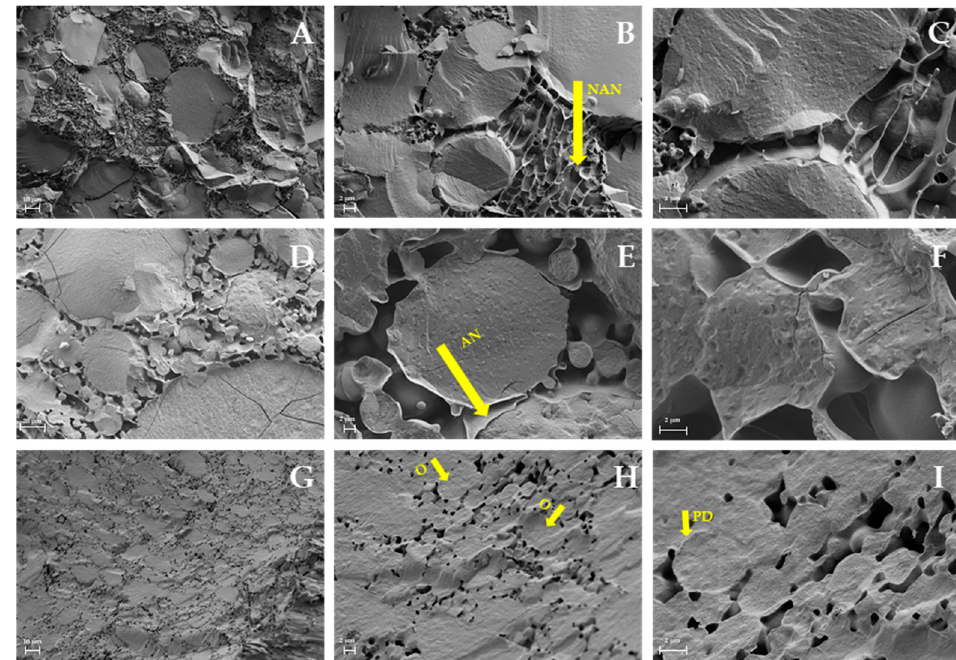
Figure 1. Microstructure of the emulsions observed using Cryo-FESEM. ( A – C ): 9H sample; ( D – F ): 12L sample; ( G – I ): 12H sample. ( A , D , G ): 500× magnification; ( B , E , H ): 2000× magnification; ( C , F , I ): 5000× magnification. Arrow NAN: non-adsorbed polymeric network; arrow AN: adsorbed polymeric network; arrow O: oil droplet; arrow PD: more polyhedric shape. ( A , G ) scale bar 10 μ m; ( B , C , E , F , H , I ) scale bar 2 μ m; ( D ) scale bar 20 μ m.